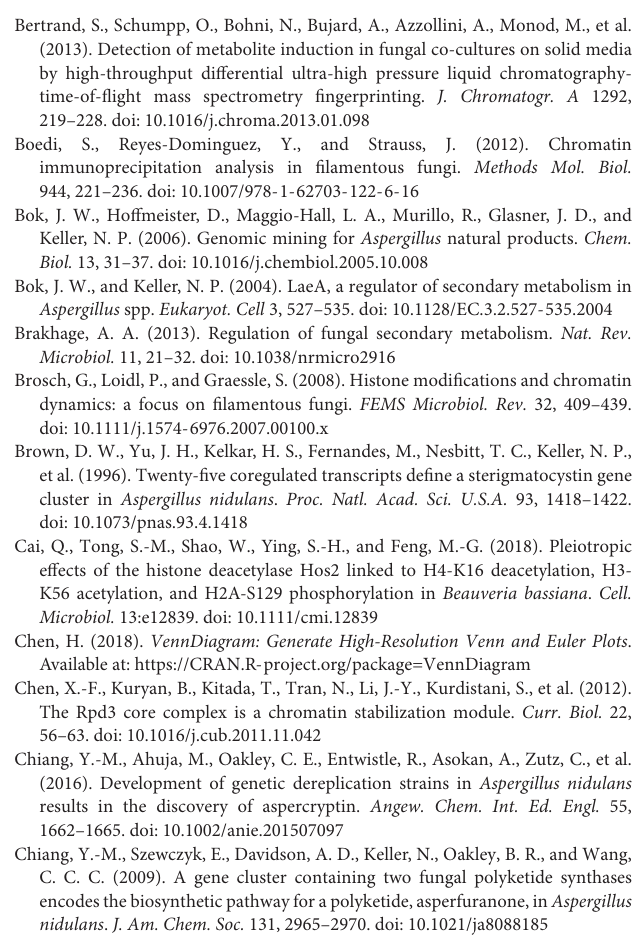
TABLE S2 | Oligonucleotides used for qPCR and generation of probes. Primers for qPCR of the ChIP analysis are listed; three different regions (T1, T2, T3) in each of the corresponding SM cluster genes were used for quantification of precipitated DNA (left column). Primer pairs used to generate Dig-dUTP-labeled DNA probes for transcriptional analysis in Northern blots are shown (right column). PN, penicillin; OA, orsellinic acid; CC, cichorine; AC, aspercryptin. TABLE S3 | TopHat summary of mapped reads of each RNA-Seq sample. Table shows the amount of input reads (reached from Illumina HiSeq Single Read sequencing), successfully mapped reads and number of reads aligned multiple times to the reference genome. TABLE S4 | Genes represented in Venn-diagrams and used for FunCat classification ontology analysis. Listed genes are the result of filtering Cuffdiff results of 10.820 genes for Cuffdiff-significance, FDR ( < 0.05) and log2FC ( ≥ 2). Genes that are regarded as being differentially expressed between wildtype and hosA deletion mutant grown for 24 and 60 h are shown. Genes are divided into up- and down-regulated transcripts including those that are overlapping in both conditions. TABLE S5 | Collection of 70 confirmed or predicted genes encoding polyketide synthases or non-ribosomal peptide synthetases responsible for the biosynthesis of secondary metabolites. Detailed information about the type of enzyme, gene description, locus of the coding sequence in the genome and the compound, which is biosynthesized by the gene cluster is given (data sheet 1). Expression